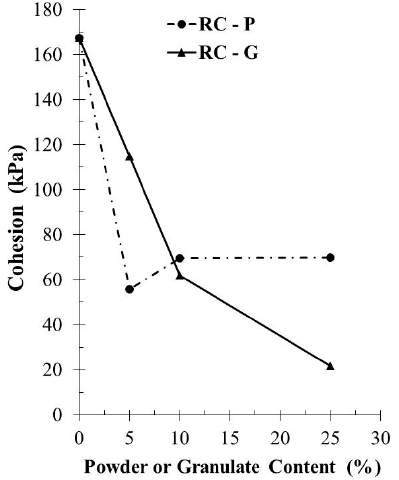
Figure 5. Variation of the cohesion with the rubber waste content.